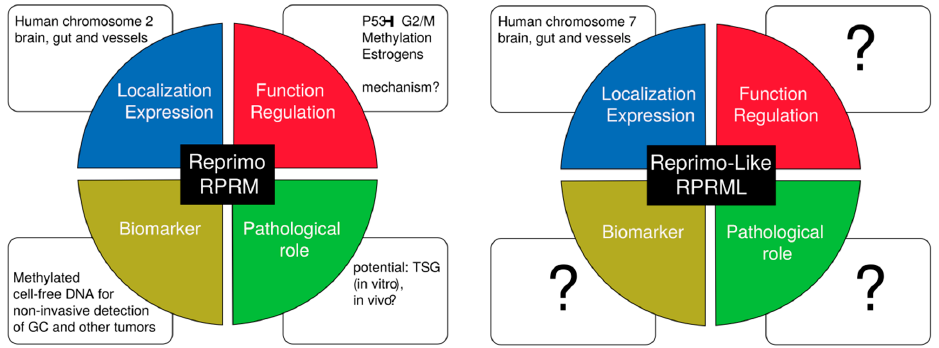
Figure 5. Unanswered questions in RPRM gene family. RPRM is as a p53-induced protein which induces cell cycle arrest at the G2/M checkpoint [4], through an unknown mechanism. Recently, RPRM genes have been shown to be expressed during brain, gut and blood vessel development [2]. Additional functions for RPRM include its role as a potential tumor suppressor gene (TSG), and a biomarker—through the assessment of the methylation status of its promoter region—for non-invasive detection of gastric cancer and other tumors [48,62]. Much like RPRM , RPRML is also expressed during embryonic development [2], but its role in physiological processes has never been investigated.